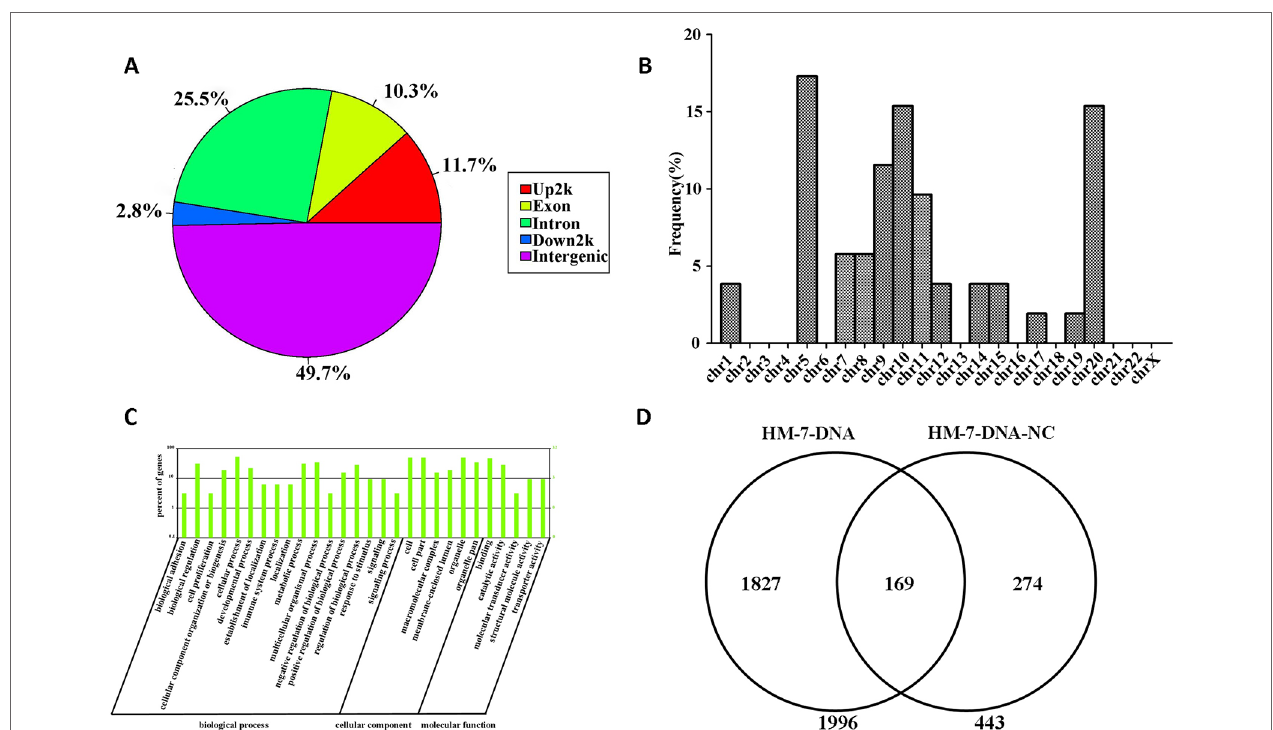
FIGURE 6 | Screening genomic sequences by next-generation sequencing. (A) The distribution of functional elements of DNA sequences in HM-7-DNA. (B) The chromosomal location of potential target genes in HM-7-DNA. (C) Gene ontology analysis of peak-related gene of HM-7-DNA. (D) Differential analysis of the potential target genes of HM-7-DNA and HM-7-DNA-NC.